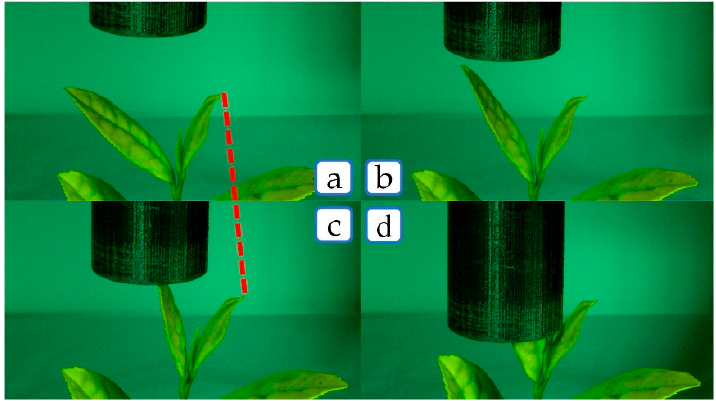
Figure 14. Descent position is the center of the first leaf span. ( a ) initial state, ( b ) Guidance start, ( c ) During guidance, ( d ) End of guidance.